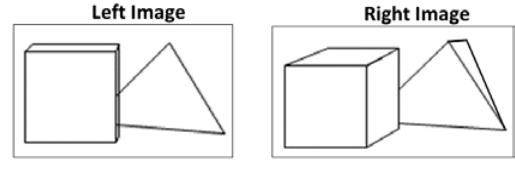
Figure 1. Difference of left and right